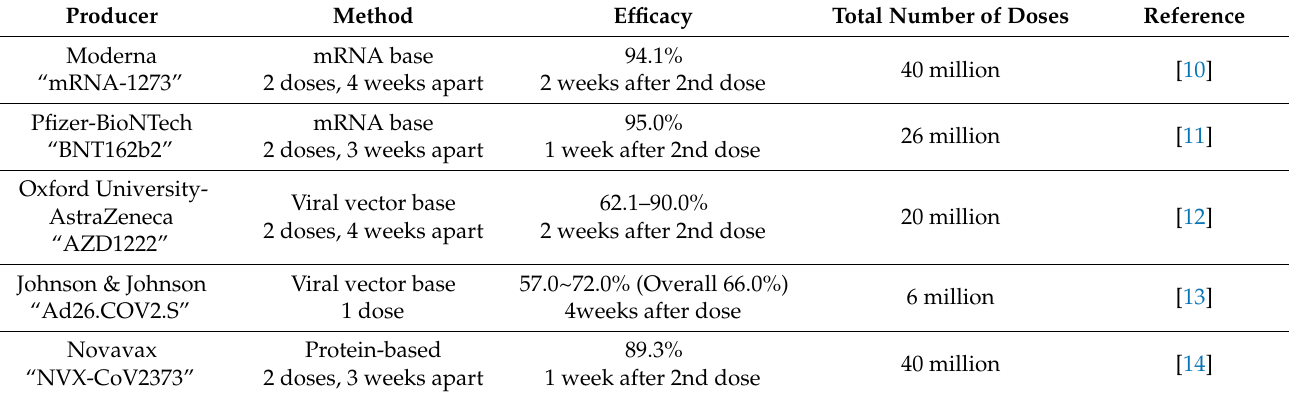
Table 1. Description of